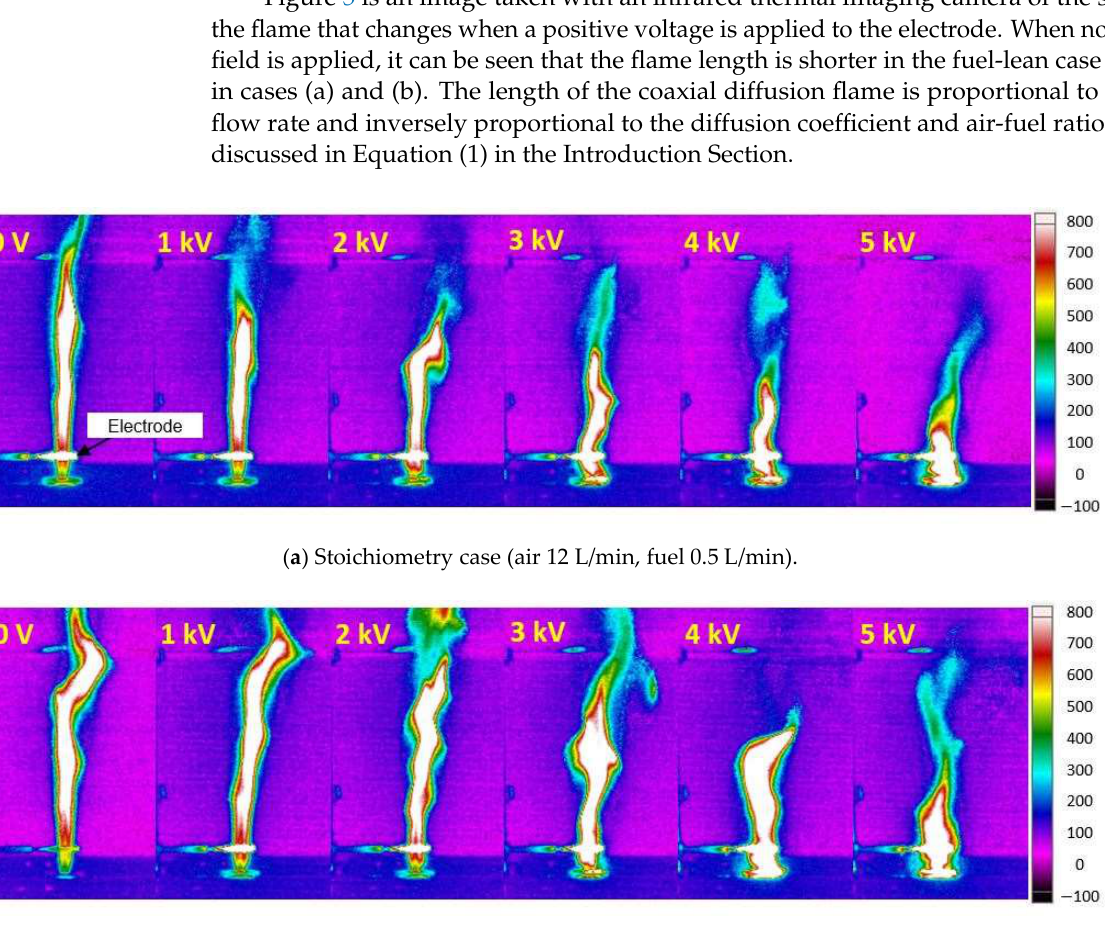
Figure 4. The change in flame shape by electric field.